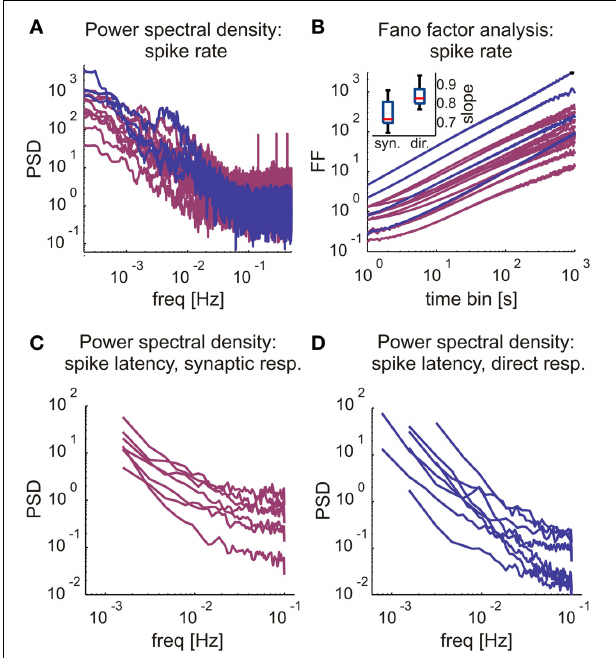
FIGURE 5 | Long-term response rate and latency dynamics in direct and synaptic responses. (A) Firing rate periodogram, comparing synaptic (magenta) to direct (blue) response fluctuation statistics plotted on a log-log scale. (B) Fano Factor characteristics across various bin sizes, comparing synaptic (magenta) to direct (blue) response fluctuation statistics plotted on a log-log scale. Inset: Boxplot of the estimated slopes ( α D ) of the Fano factor curves. Note that the scaling exponents of the Fano Factor do slightly differ in the two stimulation regimes, in directly evoked spikes they are higher (0.85 ± 0.062, mean ± SD ; n = 9) compared to those estimated from synaptically evoked activity (0.755 ± 0.074, mean ± SD ; n = 10). Boxplot: horizontal red line, median; blue box, 25th–75th percentile, red cross, outlier. In (A,B) , analyzes were done according to Gal et al. (2010) made on direct responses. Therefore, focusing on synaptic response statistics, only four direct response rate statistics were plotted as a reference, yet all were included in slope comparisons. (C,D) Power spectral densities of the latency values of synaptic (left) and direct (right) responses in modes of sporadic firing. PSD calculated with Welch’s method (bin size = 5s). Neurons showing global trends in spike rate, latency and amplitude were excluded, as well as neurons with a significant probability ( > 5%) of empty bins. Responses were classified to synaptic ( n = 7) and direct responses ( n = 8) as described